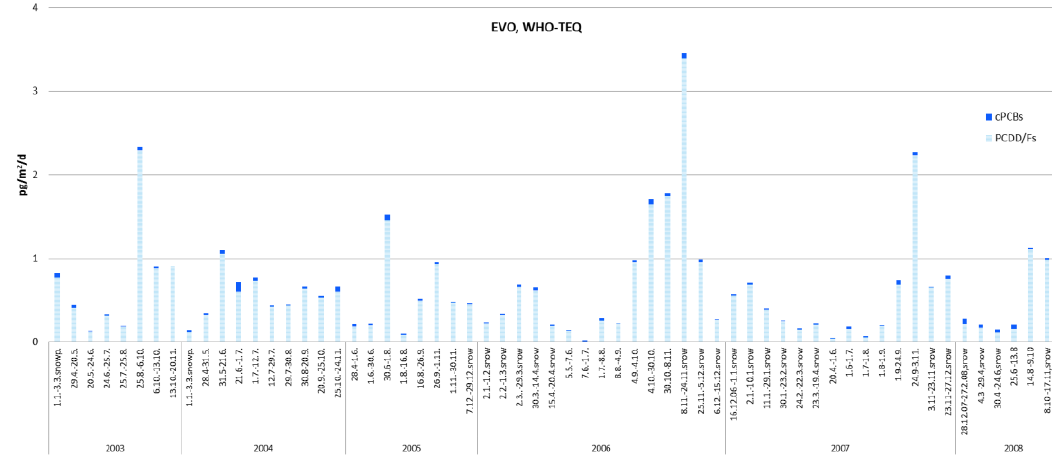
Figure 3. The deposition sample results of PCDD/Fs and cPCBs (pg/m 2 /day) in Evo in years measured the whole year (snowp. = snowprofile and snow = recently fallen snow). Table 2. The deposition of PCDD/Fs and cPCBs calculated as WHO-TEQ [34] (pg/m 2 /day) in some countries, rural (R)/urban (U) (Wallenhorst, Bakogly, Vikelsoe, and Chi I-TEQ).